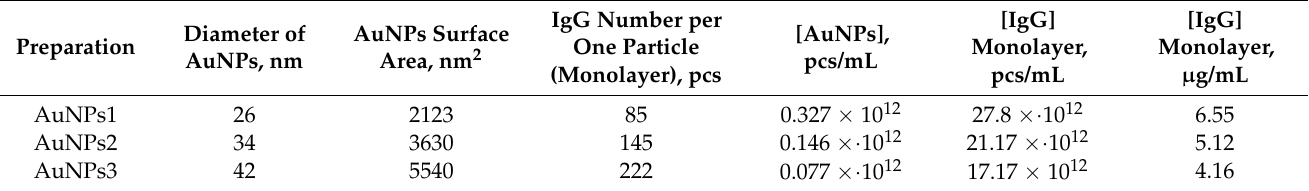
Table 2. Parameters of AuNPs1, AuNPs2, and AuNPs3 and the calculated amount of MAbs for monolayer formation.